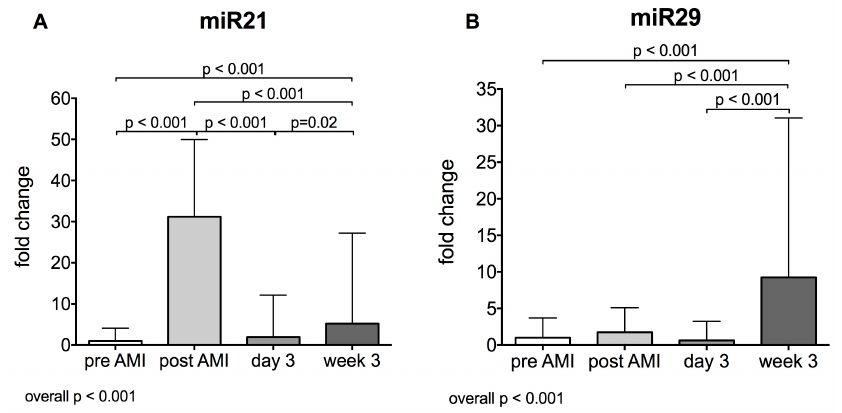
Figure 4. miR21 ( A ) and miR29 ( B ) before acute myocardial infarction (AMI), after AMI, on day 3 and week 3 after AMI ( n = 24).